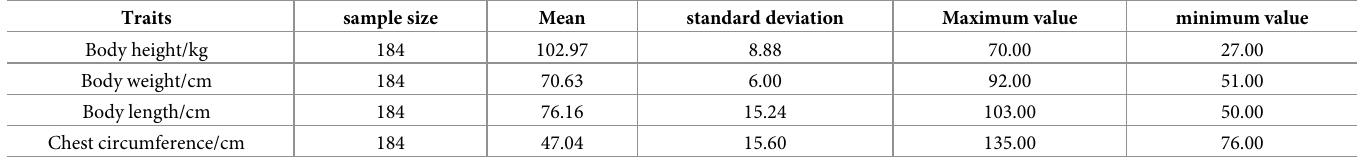
Table 2. Descriptive statistics of population growth traits of Qira Black sheep and German Merino sheep.